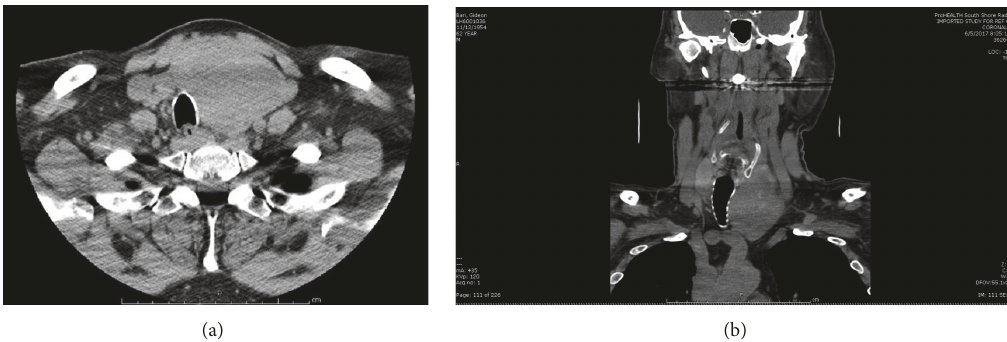
Figure 2: Preoperative neck CT without contrast, demonstrating a large left thyroid lobe mass with displacement of the trachea, mild compression, and early substernal extension; representative axial (a) and coronal views